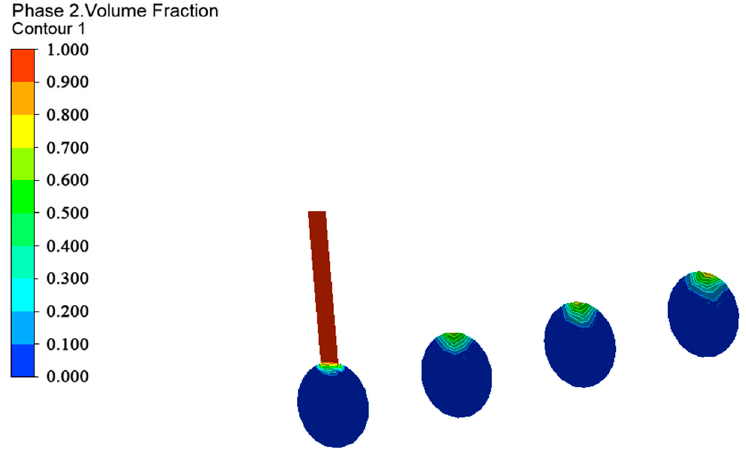
Figure 9. Volume fraction of the fertilizer of horizontal section at 4 s.